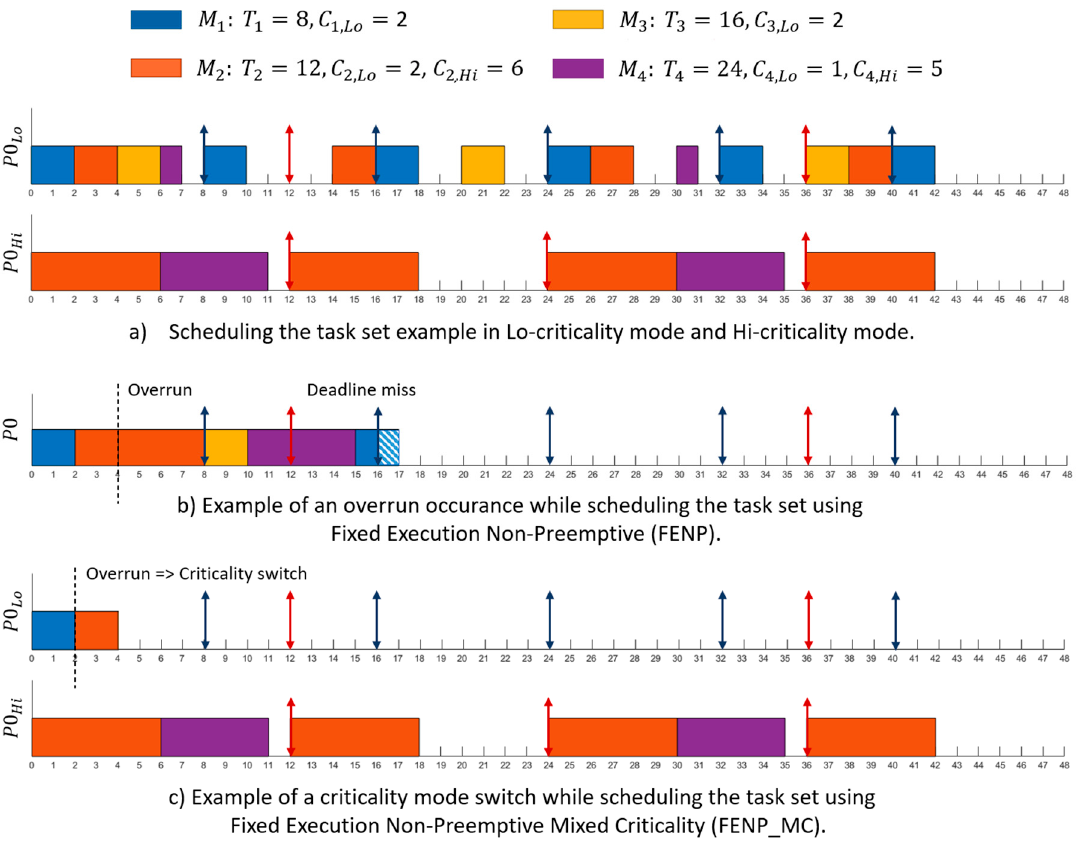
Figure 3. Example of a criticality mode switch.